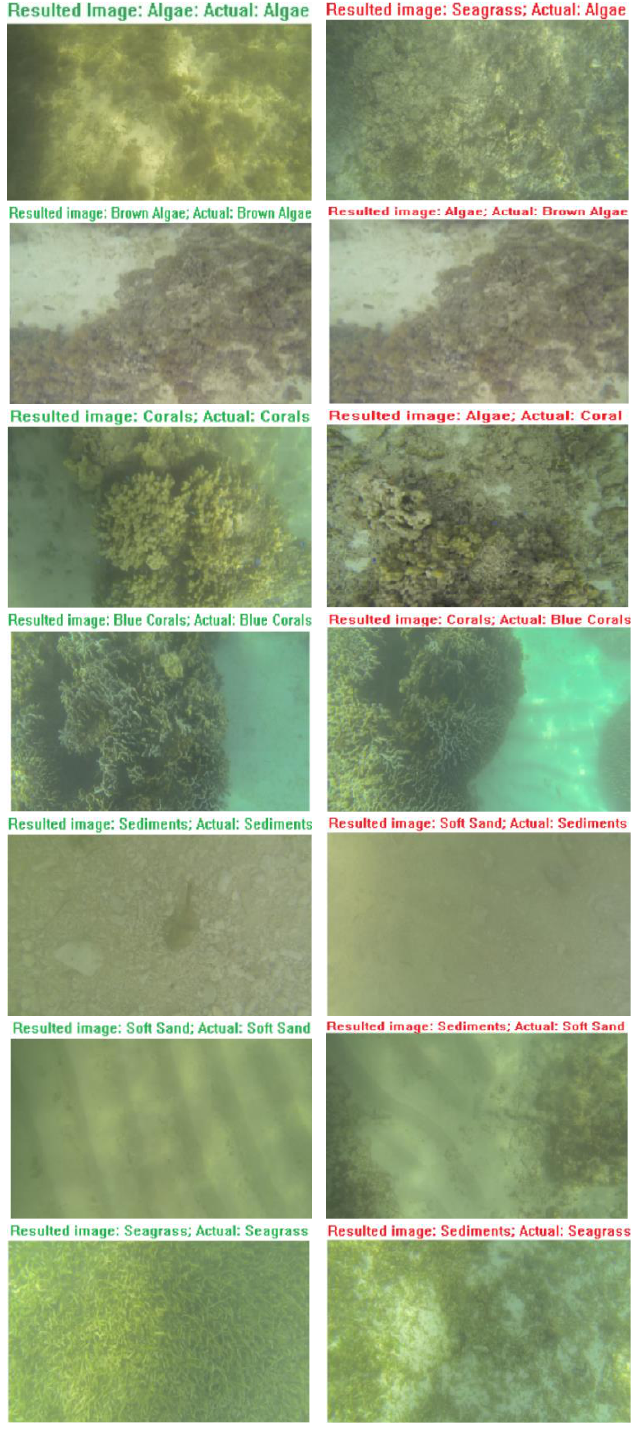
Figure 5. Samples of the correct (green) and misclassified (red) benthic cover images over the Shiraho area.